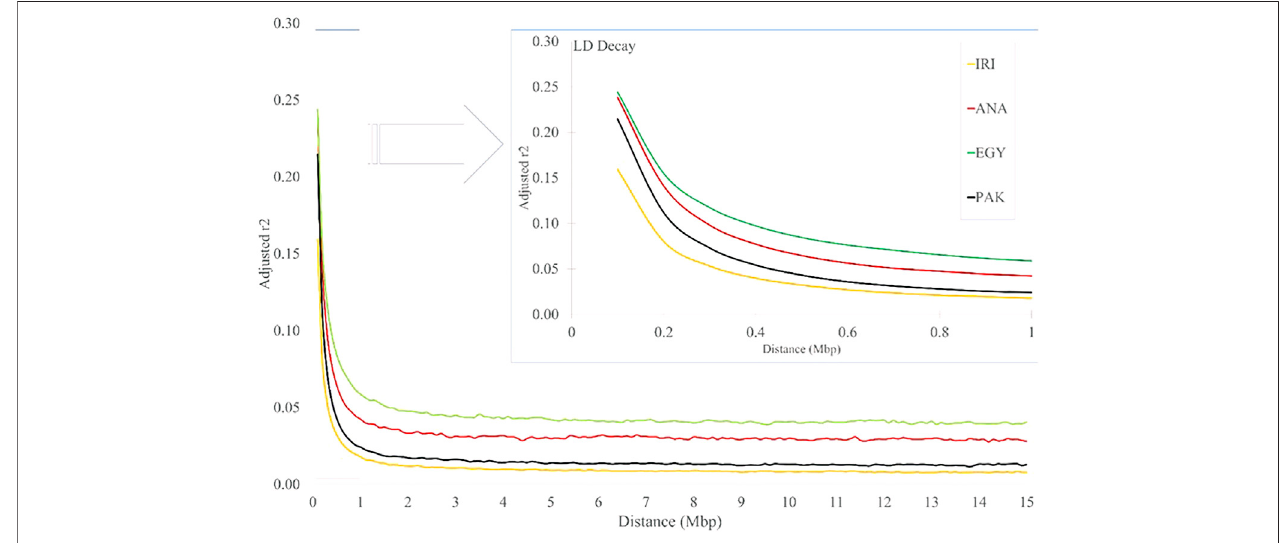
FIGURE 3 | LD decay for increasing distance (Mb) for IRI, ANA, EGY, and PAK water buffalo populations.